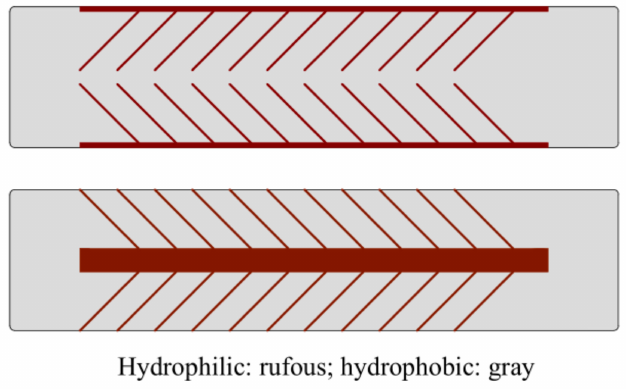
Figure 9. Schematic detailing hydrophobic/hydrophilic patterned surfaces